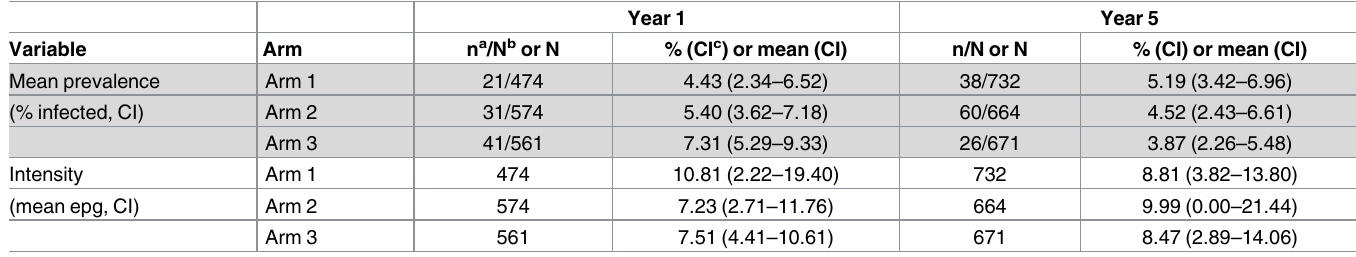
Table 5. Prevalence and intensity of S . mansoni infection for first year students in each arm at baseline (Year 1) and final evaluation (Year 5).